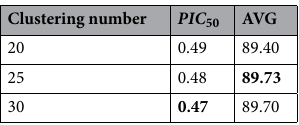
Table 6. Comparison of the number of clusters. Significant values are in